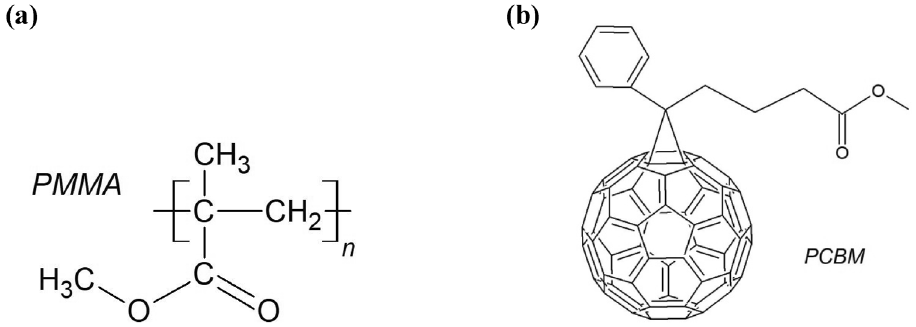
Figure 1. Chemical structures of ( a ) poly(methyl methacrylate) (PMMA) and ( b ) [6,6]-phenyl-C61-butyric acid methyl ester (PC 61